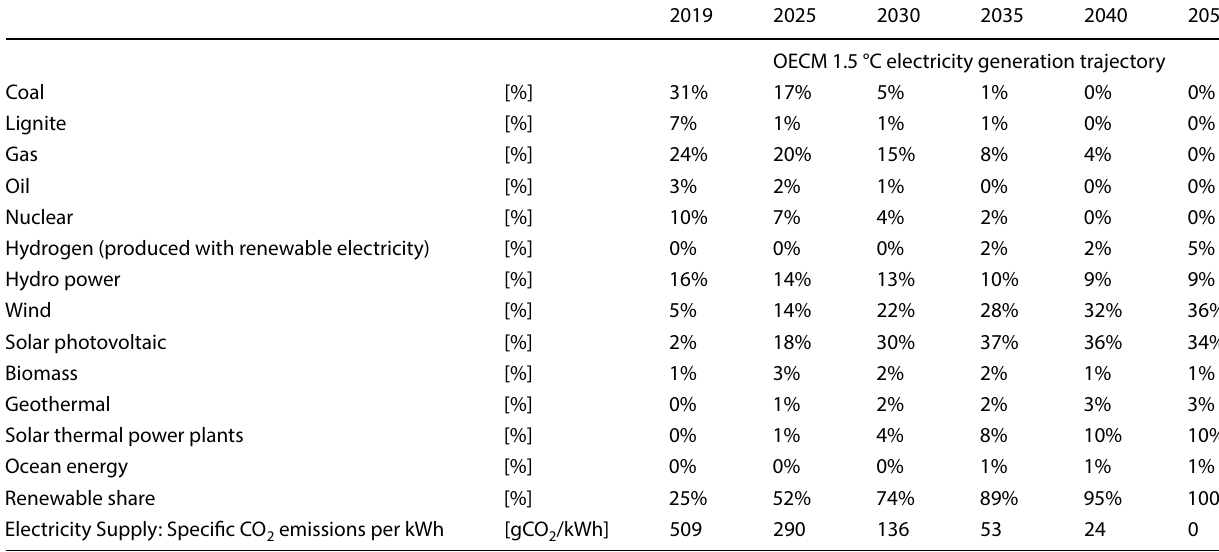
Table 12 Results: Global electricity supply under the OECM 1.5 °C pathway